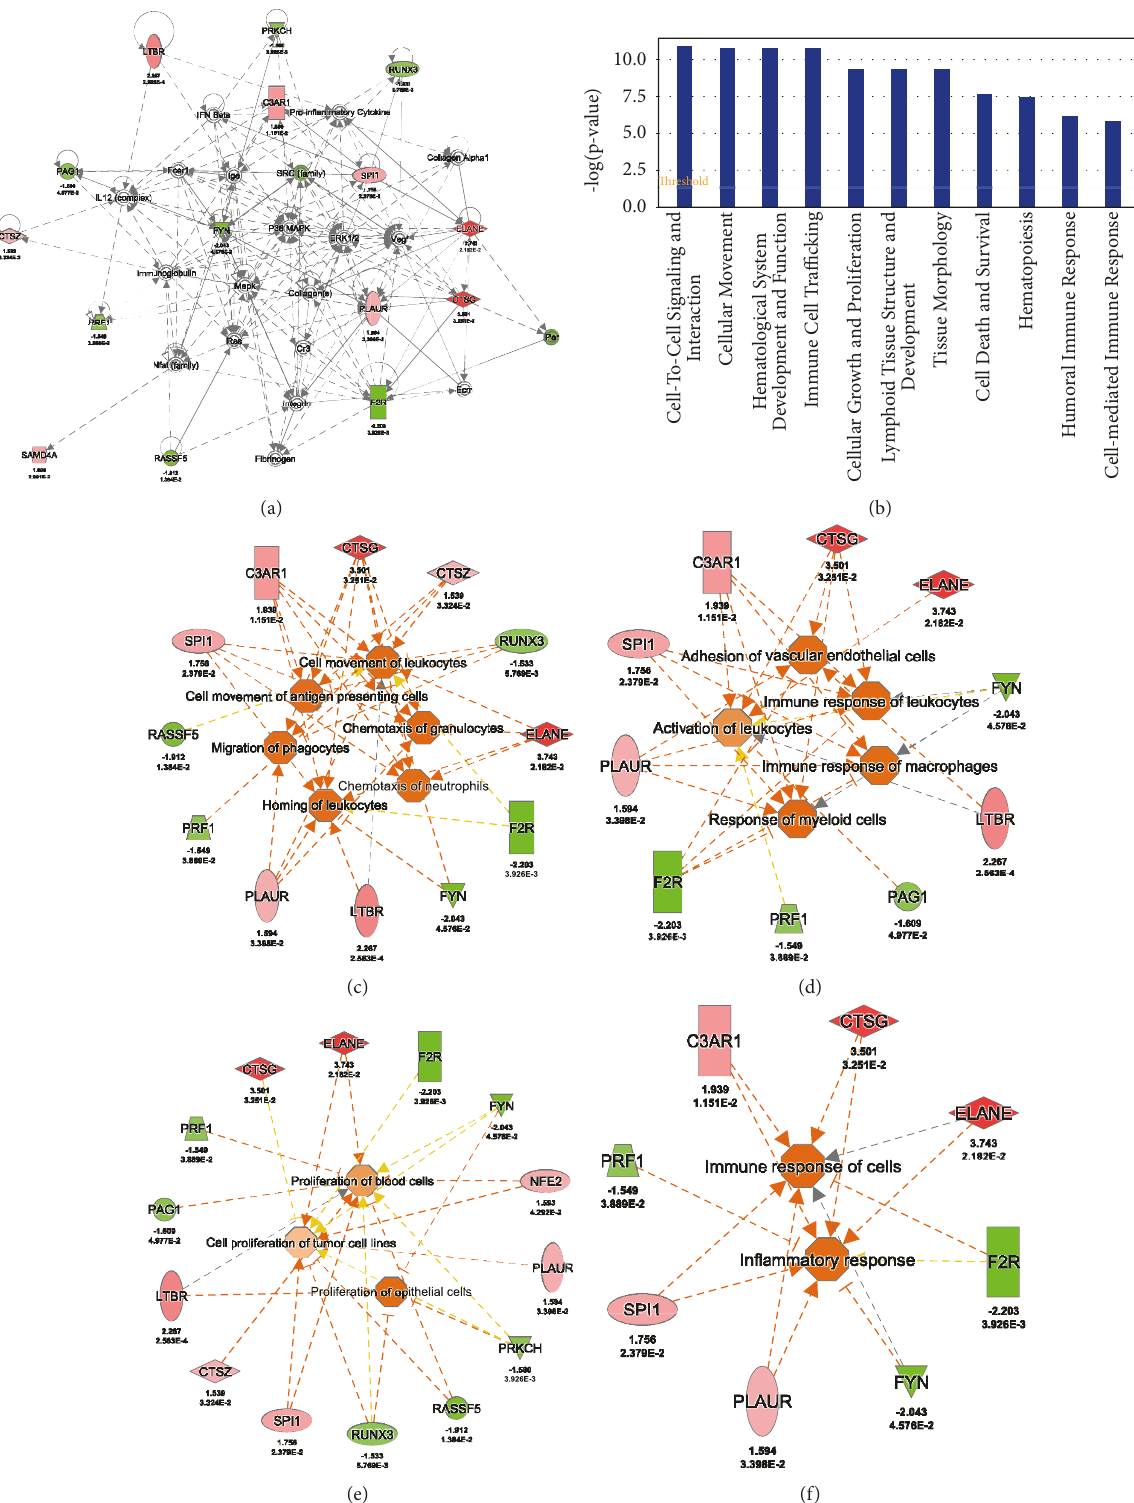
Figure 6: Thediseasesandfunctions analysisbyintegrated pathwayanalysisusing 20 Me D EGs. (a) The top interactionnetworks involved by 15 MeDEGs. (b) Canonical pathway analysis of 20 MeDEGs in PBMC from SSc patients as compared with normal controls. Statistically significant pathways were shown. (c) Most genes (12/20) are involved with cell movements of leukocytes, cell movement of antigen presenting cells, migration of phagocytes, chemotaxis of granulocytes, homing of leukocytes, and chemotaxis of neutrophils. (d) The network from 10 DEGs is involved with adhesion of vascular endothelial cells, immune response of leukocytes, activation of leukocytes, immune response of macrophages, and response of myeloid cells. (e) Most genes (12/20) are involved with proliferation of blood cells, cell proliferation of tumor cell lines, and proliferation of epithelial cells. (f) The network from 8 genes is involved with immune response of cells and inflammatory